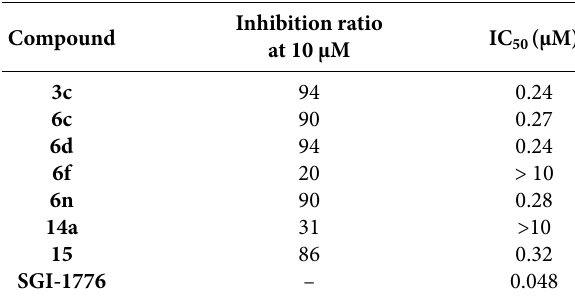
Table 3. The inhibitions of compounds 3c , 6c , 6d , 6f , 6n , 14a and 15 against Pim-1 kinase.